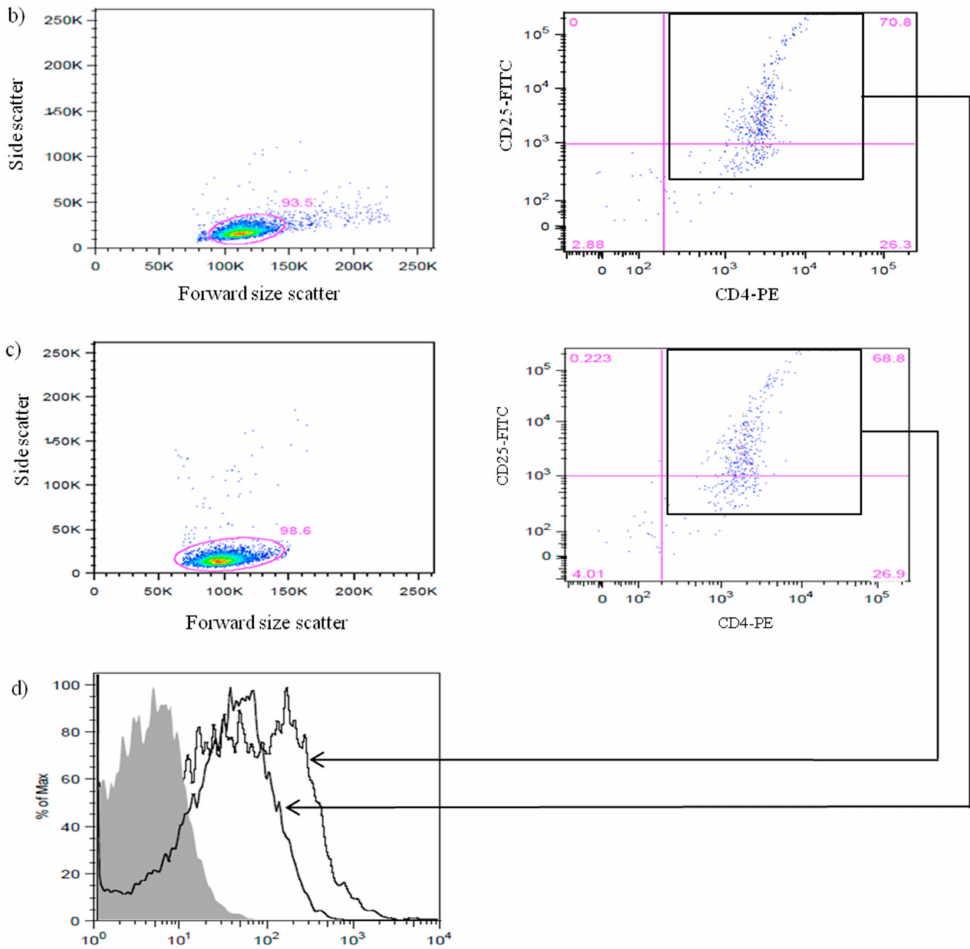
Figure 1. Efficiency of CD4 + CD25 + expressing Foxp3+ Treg isolation from Non-Obese Diabetes (NOD) and Non-Obese Diabetes Resistant (NOR) mice splenocytes. ( a ) Dot plot representing lymphocytes stained with IgG1-PE and IgG2a-FITC isotype controls. ( b ) Dot plot shows lymphocytes stained with PE-conjugated rat anti-mouse CD4 and FITC-conjugated rat anti-mouse CD25 from NOD mice. ( c ) Dot plot shows lymphocytes stained with PE-conjugated rat anti mouse CD4 and FITC-conjugated rat anti-mouse CD25 from NOR mice. ( d ) Histograms show the expression of Foxp3 + cells gated on CD4 + CD25 + populations from NOR mice (arrow) and NOD mice (arrow), compared with the isotype control (filled grey). Data shown are representative of three independent experiments. ( n = 3